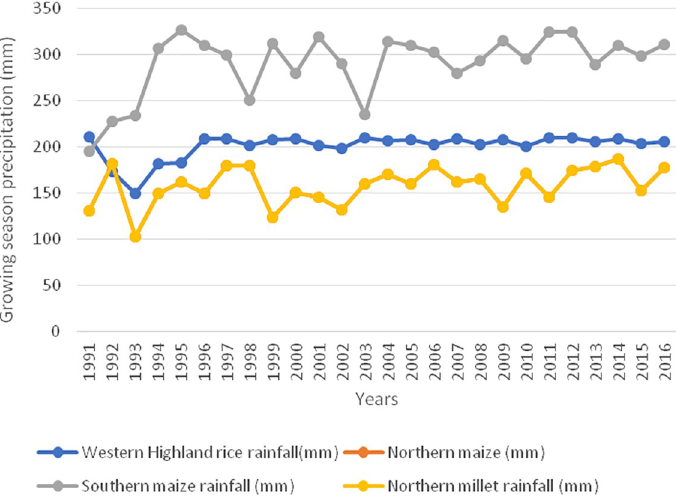
Fig 10. Sub-national growing season precipitation trends for Western Highland rice, Southern maize, Northern maize, and millet. �� northern maize and millet are computed from the same growing season precipitation, reason why they are identical i.e., growing season for Northern millet equals growing season for northern maize. Source: Authors’ conceptualization.